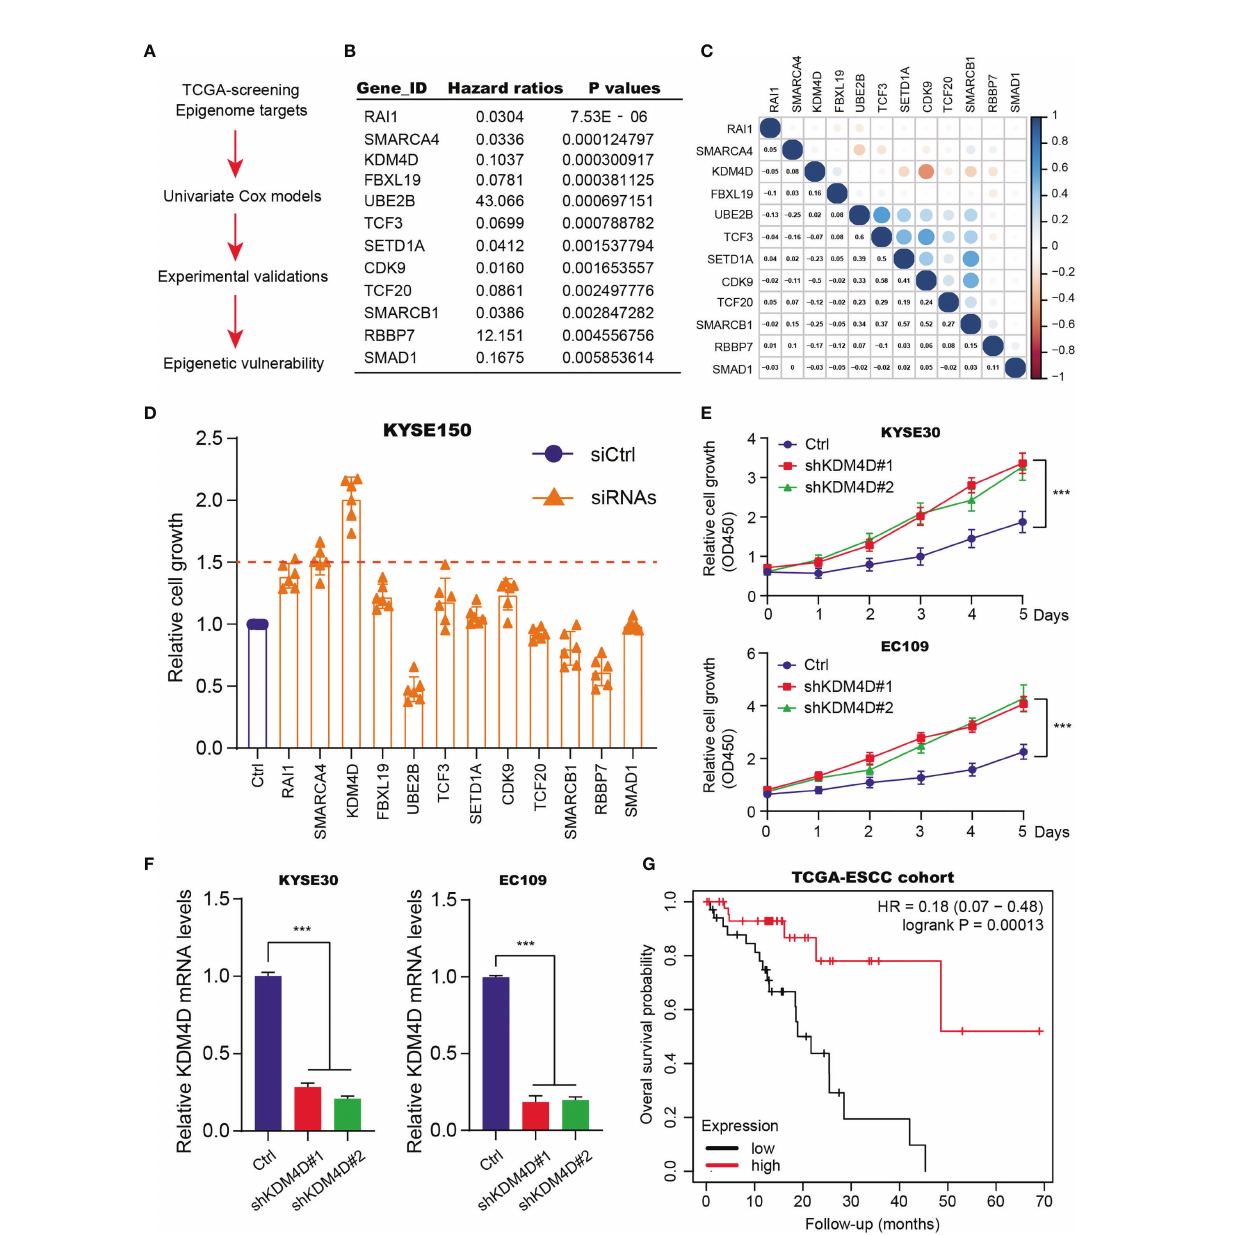
FIGURE 1 | Identi fi cation of KDM4D as a prognostic factor for ESCC. (A) Screening procedure of epigenetic factors with prognostic signi fi cance in ESCC. (B) Exhibition of partial results of epigenetic factors based on univariate Cox regression analysis. (C) The correlation heatmap revealing the underlying associations across indicated candicates. (D) MTT assays in KYSE150 identify that KDM4D was the most potent hit. (E) Knockdown assays with speci fi c shRNAs in the KYSE30 and EC109 cell lines. (F) Detection of KDM4D mRNA levels via qPCR in cells transfected by shCtrl and shKDM4D#1 or shKDM4D#2. (G) Kaplan-Meier analysis suggesting the prognostic role of KDM4D in ESCC. * P < 0.05, ** P < 0.01, *** P <